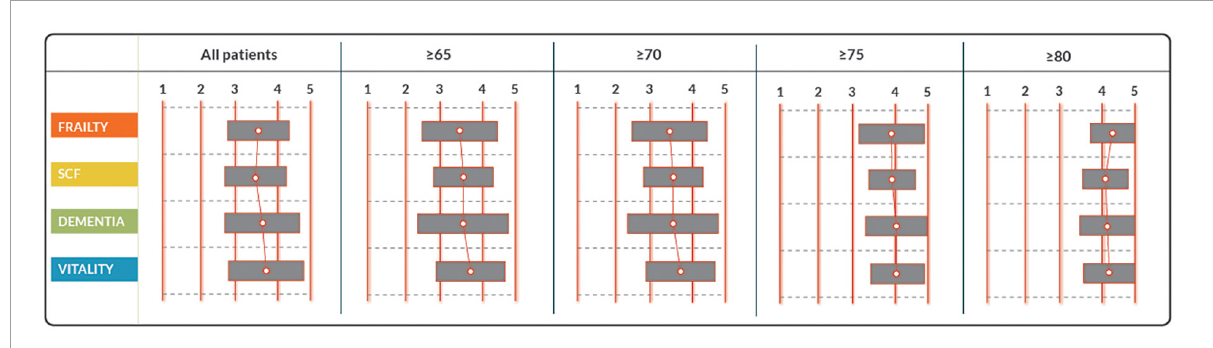
FIGURE2 Response to statements on which patients should be screened on what aspects, by tools integrated into the decision aid. Statements are rated on a scale from 1 to 5. Consensus on acceptance is reached with a median score of ≥ 3.5. SCF, social cognitive functioning.